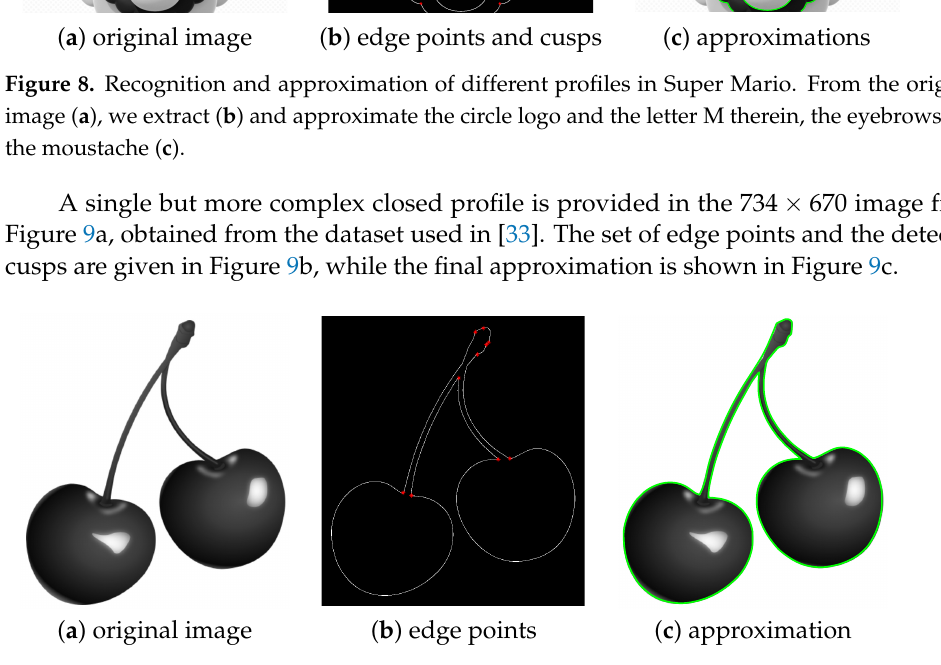
Figure 9. Recognition and approximation of a cherry profile. From the original image ( a ), we extract the edge points and identify cusps ( b ), and produce the final approximation given in ( c ).